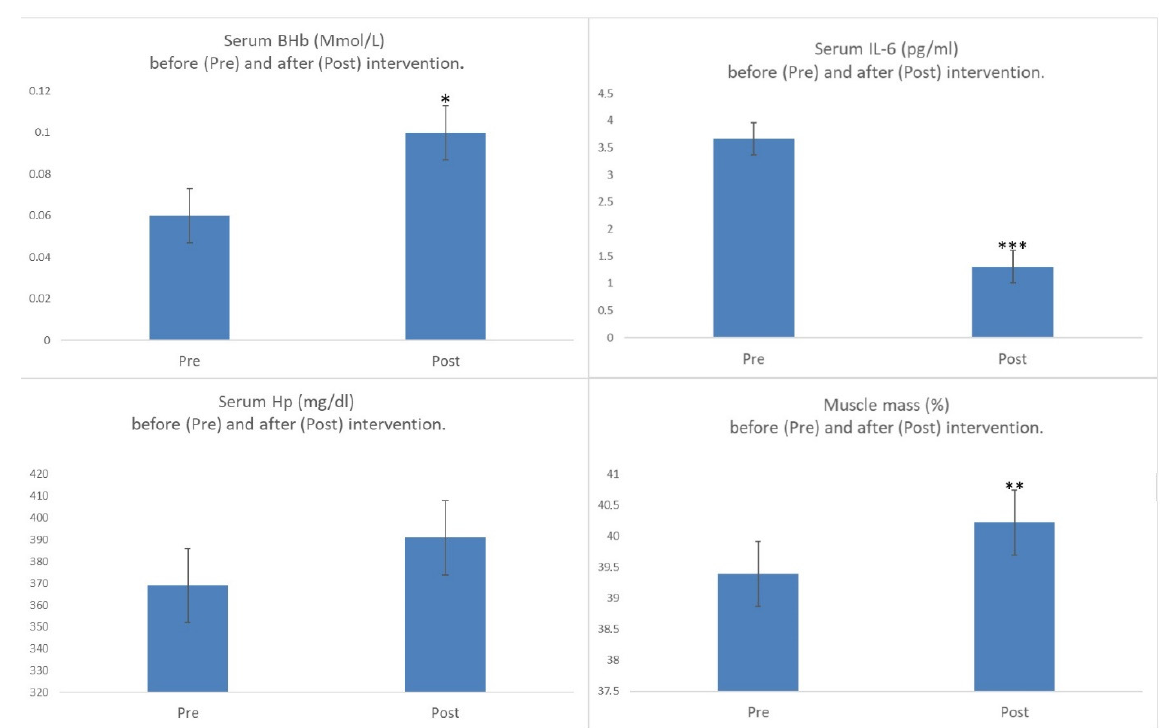
Figure 2. Changes obtained when comparing variables analyzed in serum and muscle percentage of the study population, before (Pre) and after (Post) intervention. BHB: beta-hydroxybutyrate; SD: standard deviation; IL-6: Interleukin 6 (mean value of normal IL-6 1.4 pg/mL); Hp: haptoglobin (HP); *: statistically significant differences ( p = 0.045); **: statistically significant differences ( p = 0.03). ***: statistically significant differences ( p = 0.000);